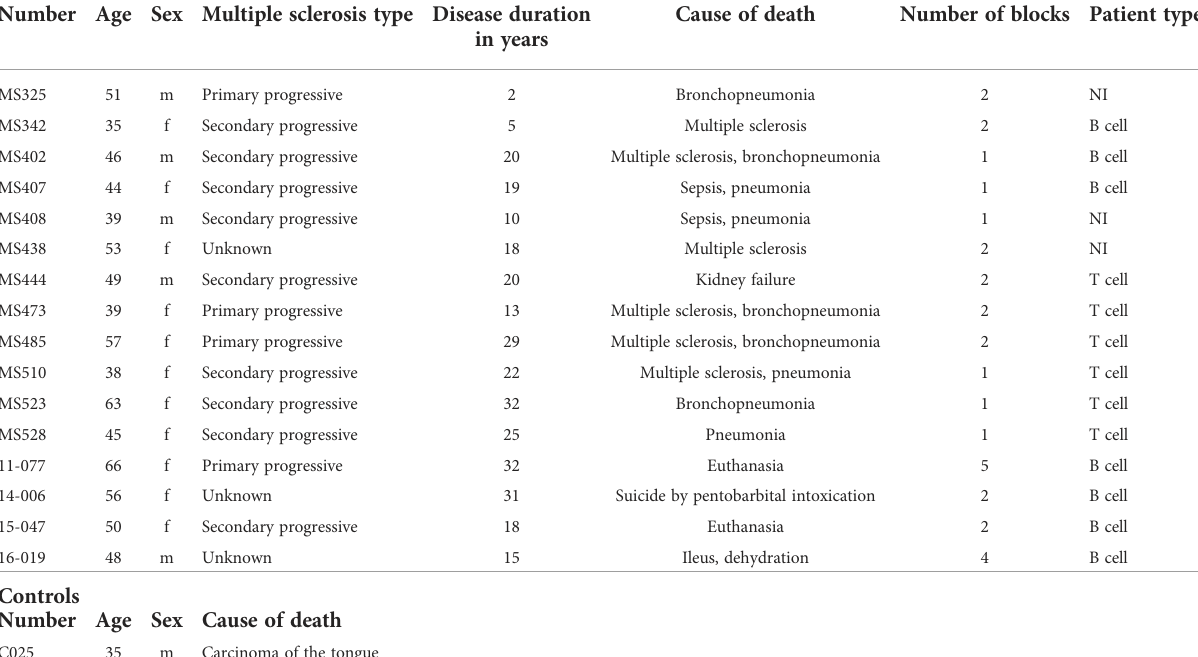
TABLE 1 Patient details. MS patients Number Age Sex Multiple sclerosis type Disease duration